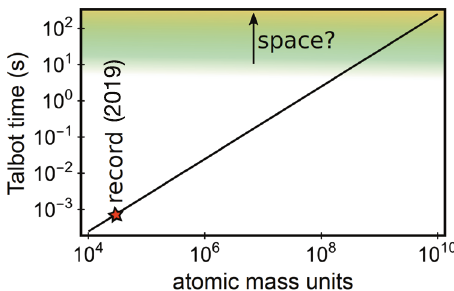
Fig. 2 Required free-fall time for growing mass particles. The free-fall time for the test particles in a near- fi eld interferometer is of the order of the Talbot time t T = md 2 / h , where m is the particle mass, h is Planck ’ s constant, and d is the grating period. In experiments with signi fi cantly higher test masses than the current record 16 (red star in the fi gure), the required free- fall time may eventually necessitate a space environment